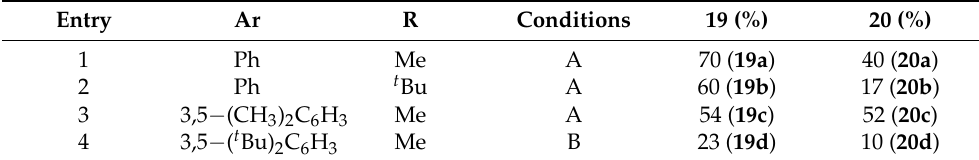
Table 1. Preparation of salts 20 .